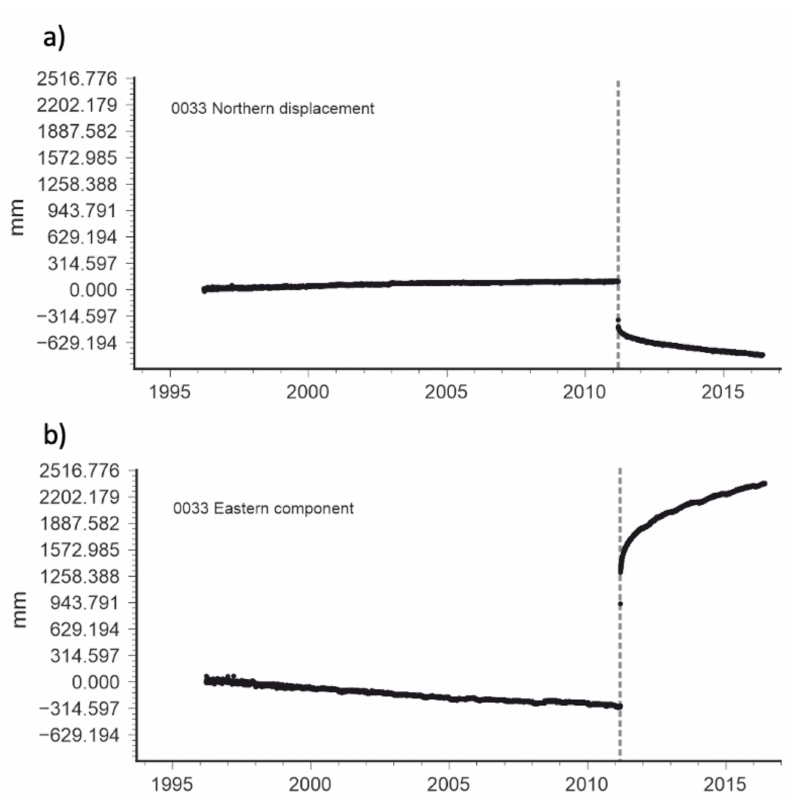
Figure 7. Timeseries for the northern ( a ) and eastern ( b ) displacement components recorded at GEONET GNSS station 0033. Dashed vertical line indicates 2011 Tohoku